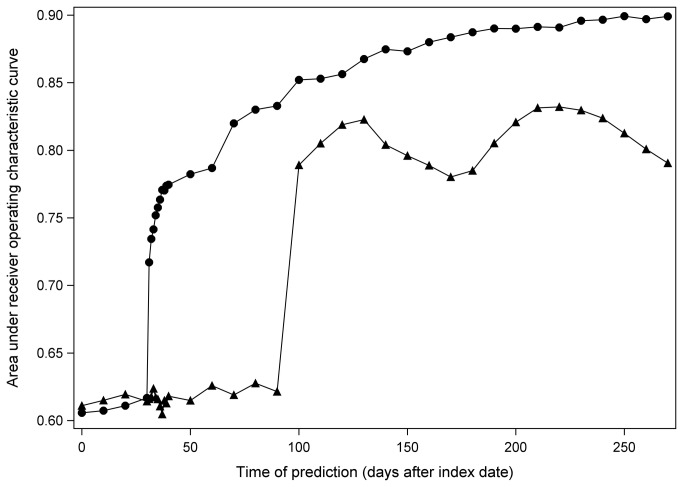
Model performance versus time of prediction.Separate curves are presented for members whose first statin fill was for 30 days or less (circles), and for members whose first statin fill was for more than 30 days (triangles). For the ≤30 day subset, performance improves sharply between days 30 and 31, and it improves steadily thereafter. However, for the >30 day subset, (most of whom had 90-day fills,) performance improves sharply only after day 90. Each Y coordinate expresses the performance of a model that uses prescription fills from days 1 to X to predict adherence from days X to 365.